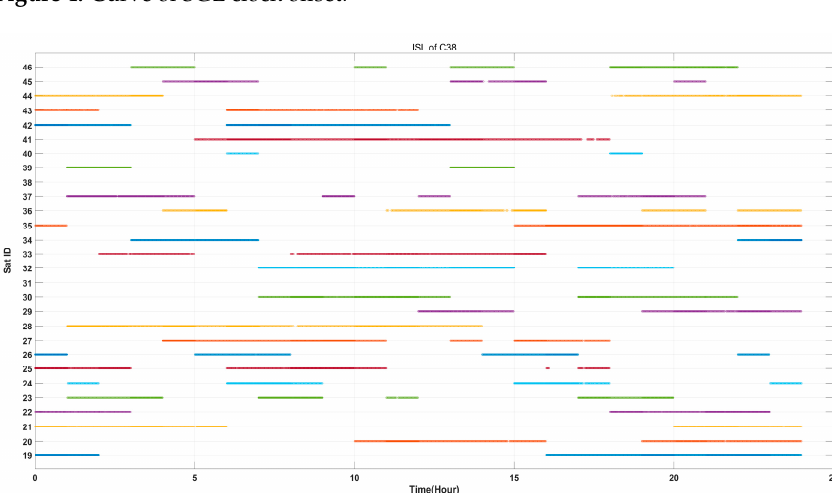
Figure 4. Curve of SGL clock offset.